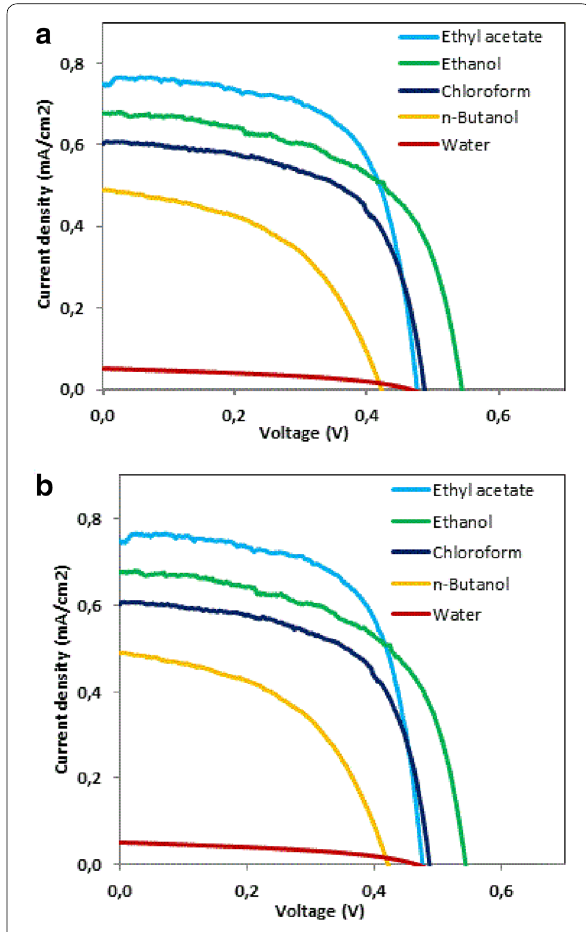
Fig. 11 Current density–voltage performances of the DSSCs assembled with a Jamaica flowers and b Mortiño fruit dyes extracted in different